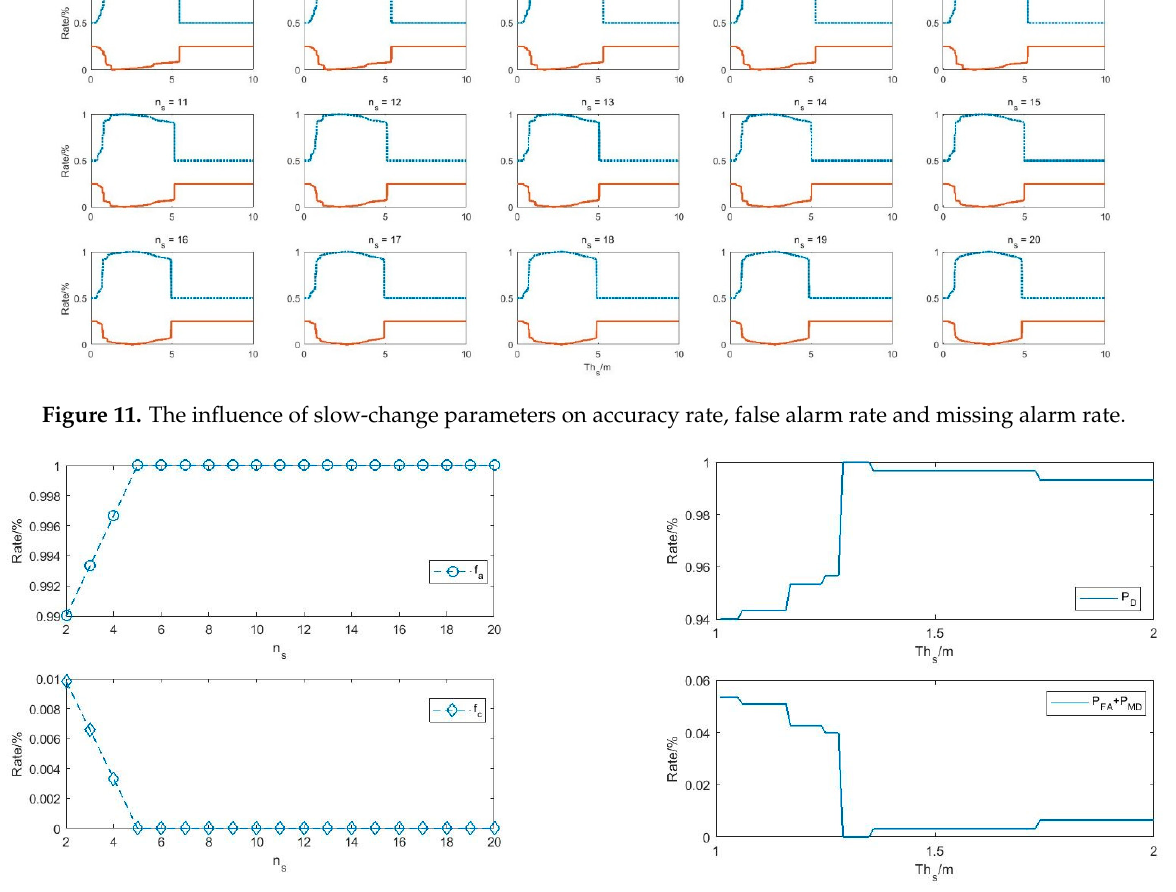
Figure 12. The impact of slow-change parameter settings: ( a ) the impact of slow-change verification window; ( b ) the impact of slow-change verification threshold ( n s =5 ).